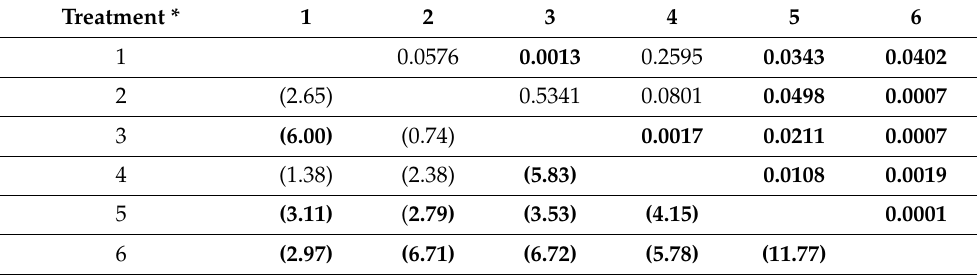
Table 4. p -value and F-test (between parenthesis) calculated for comparisons, two-to-two, of the equations adjusted for yield (m 3 ha − 1 ) projected at 60 months of age by [49] model for each treatment. Treatment